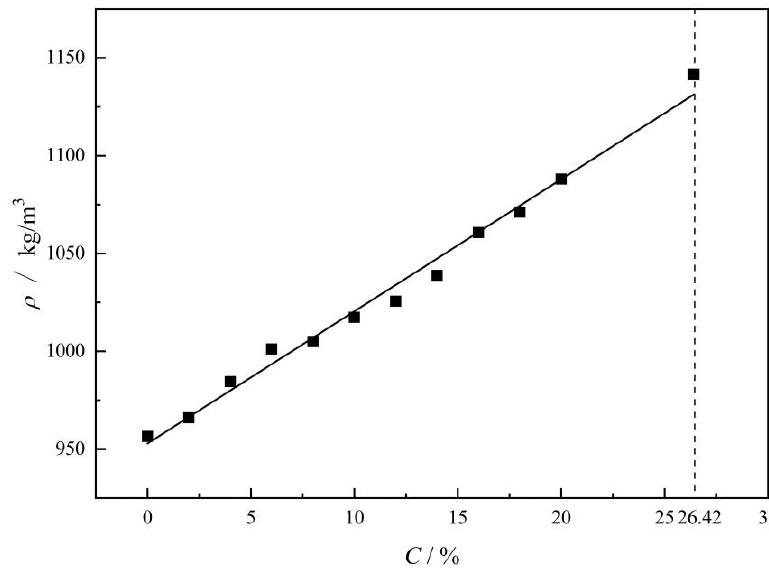
Figure 4. Relationship between mass concentration and density of NaCl solution.